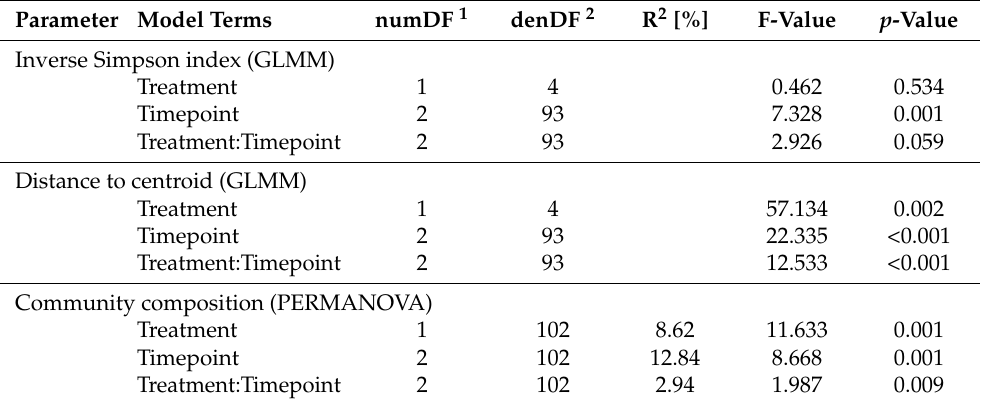
Table 1. GLMM and PERMANOVA results to assess the effects of temperature treatment and sampling timepoint on the alpha diversity (inverse Simpson index), betadispersion (distance to centroid), and composition of the milkfish gut